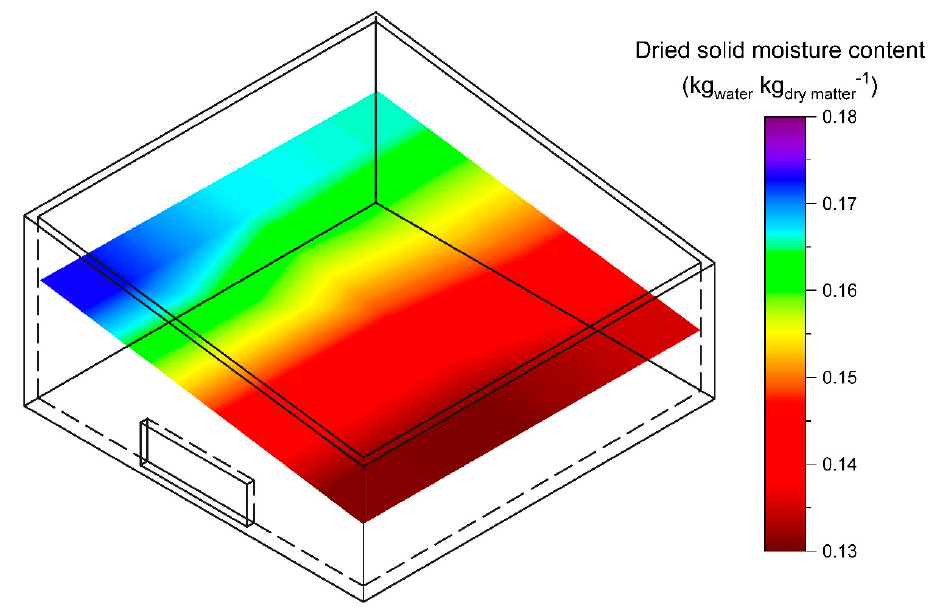
Figure 5. The moisture content of the dried cassava grits across the perforated screen of the fixed-bed dryer.